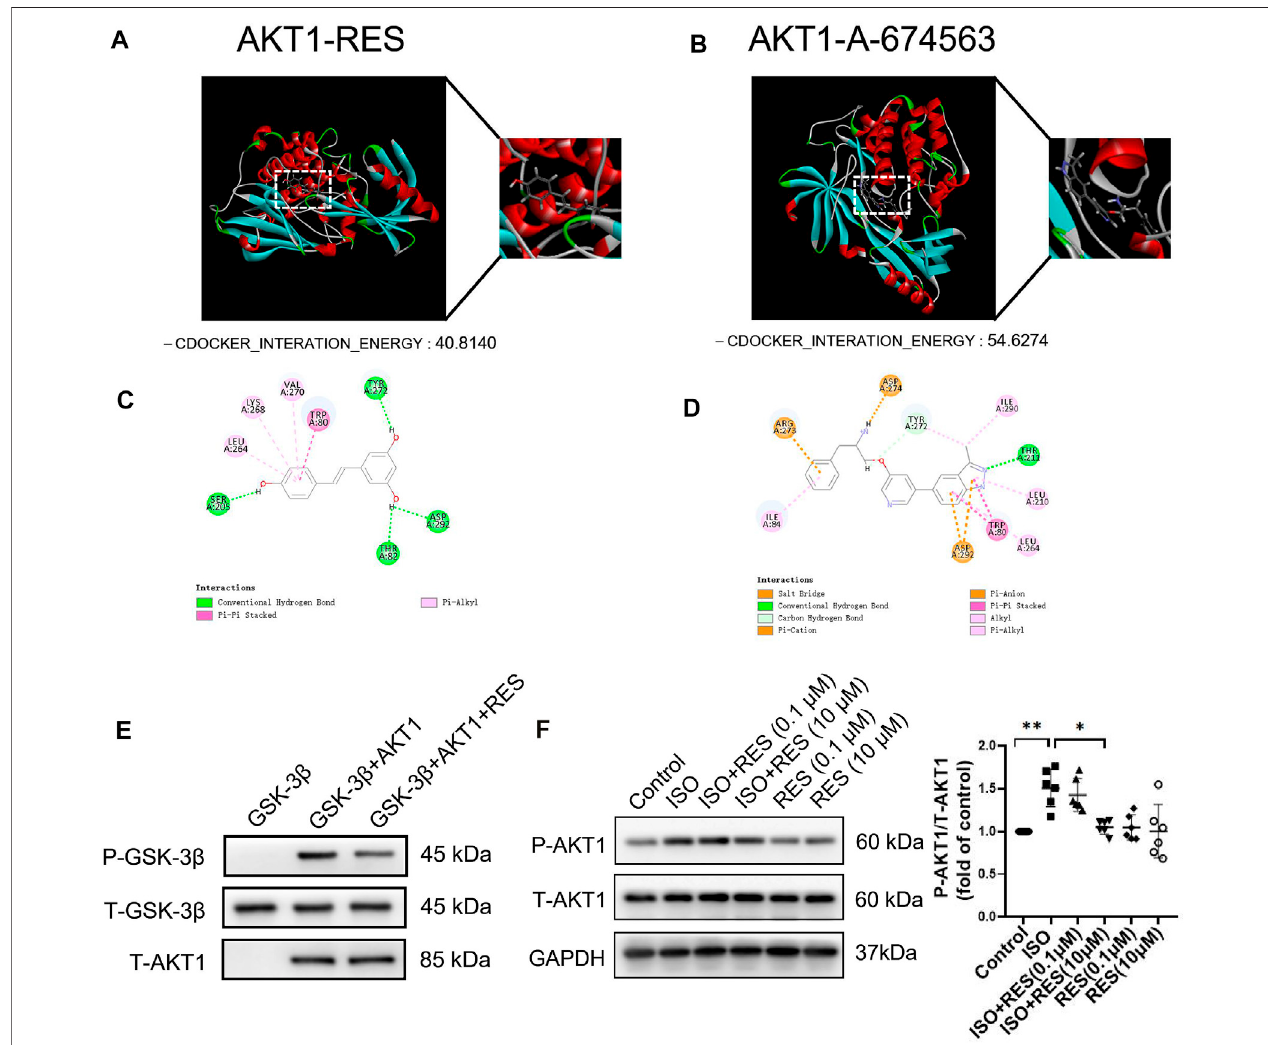
FIGURE 3 | Resveratrol improves the molecular mechanism of acute sympathetic stress-induced heart injury through AKT1. (A) Three-dimensional docking of resveratrol and AKT1. (B) Three-dimensional docking of A-674563 and AKT1. (C) Two-dimensional docking of resveratrol and AKT1. (D) Two-dimensional coupling of A-674563 and AKT1. (E) AKT1 activity in the in vitro kinase assay. Recombinant active AKT1, puri fi ed GSK-3 β and RES were added into the kinase buffer as indicated. TheAKT1kinaseactivitywasindicatedbythephosphorylationofGSK-3 β . (F) NMCMswereexposedtoisoproterenol(10 μ mol/L)for1 hwithorwithoutresveratrol (100 nmol/L)or (10 μ mol/L) pretreatmentfor 30 min. Total-AKT1 (T-AKT1) and phosphorylatedAKT1(P-AKT1) protein levels weredetected byWesternblot. n =6;* p < 0.05; ** p < 0.01; *** p < 0.001; RES, Resveratrol; ISO, isoproterenol. Data are mean ± SD (Kruskal – Wallis ANOVA with post-hoc Dunn ’ s multiple comparison tests).